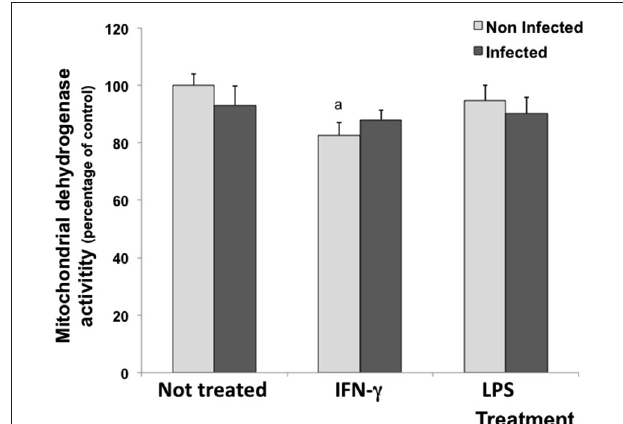
FIGURE 1 | Percentage of cell viability measured by the MTT assay in rat neuron/glial cell co-cultures treated with 300 IU/mL of IFN- γ and 1.0 mg/mL of LPS and infected with Neospora caninum tachyzoites (ratio cell:parasite 1:1) . The results are expressed as the percentage of cell viability observed in different treatment conditions and the respective standard deviation compared with untreated/uninfected control cultures (considered as 100%) 72 h post infection. The results are expressed as the mean of the percentage and the respective standard of eight samples, in three independent experiments. “a” represents a significant statistical difference when compared to untreated/uninfected control cultures; (Two-way ANOVA/Tukey’s Multiple Comparison Test— p < 0.05).